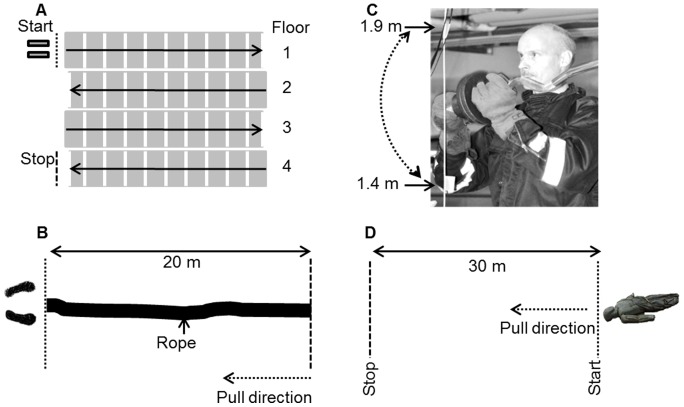
Schematic view of the work task course.The four work tasks: carrying hose baskets in a staircase (A), hose pulling (B), demolition at or after a fire (C) and victim rescue (D), was performed in sequence with two minutes of rest between each work task. The subject on the photograph has given written informed consent, as outlined in the PLOS consent form, to publication of their photograph.